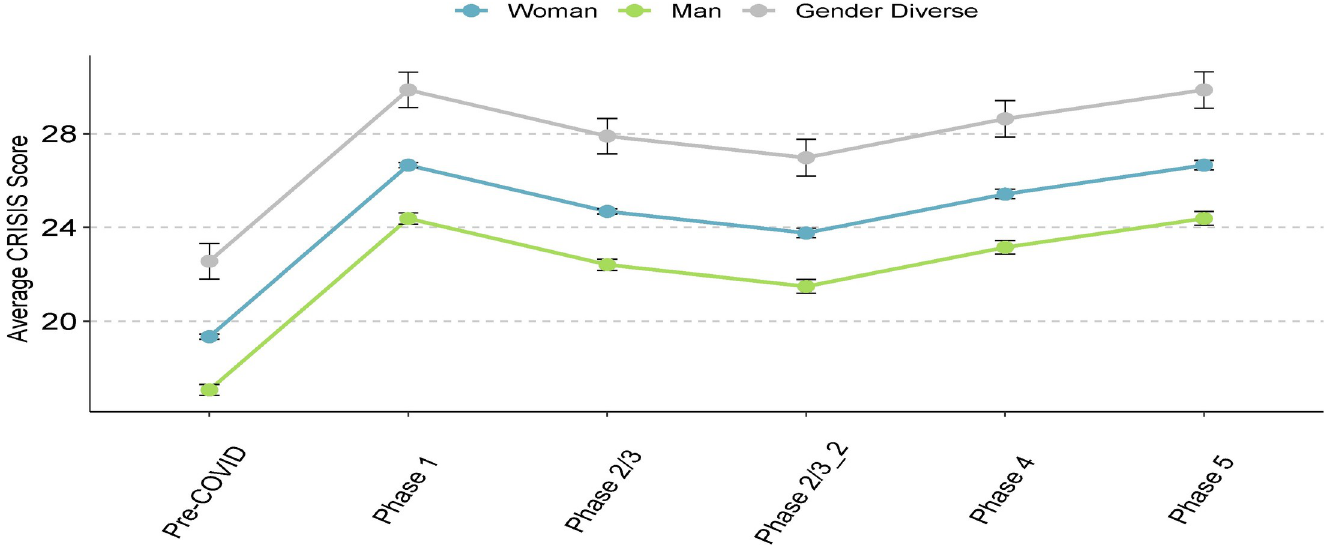
Fig 4. Pandemic stress symptoms, as measured by the CoRonavIruS Health Impact Survey (CRISIS), across phases of the pandemic. Data points refer to mean scores of the given psychosocial measure, error bars refer to the standard error. Pre-COVID: Prior to mid-March 2020; Phase 1: Mid-March 2020 to mid-May